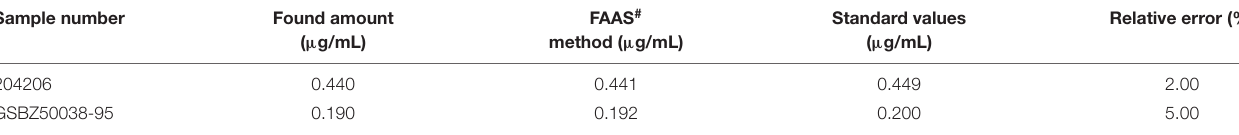
TABLE 5 | Results for the determination of Ag(I) in Certified Reference Material. Sample number Found amount ( µ g/mL)